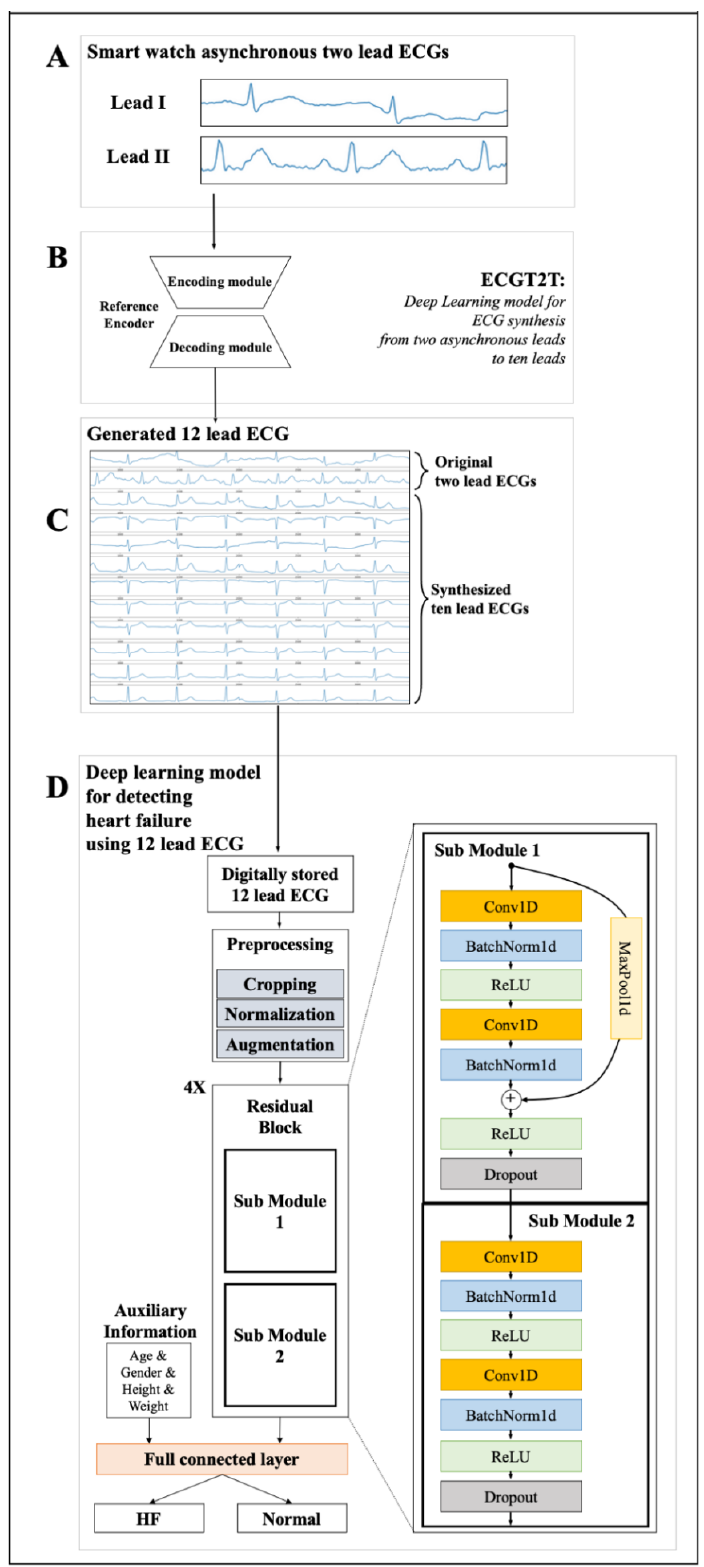
Figure 2. Architecture of deep learning model for detecting heart failure. Legend: ECG denotes electrocardiography, ECGT2T ECG synthesis from two-lead to ten-lead, and HF heart failure. ( A ) Asynchronous two lead ECGs from smart watch. ( B ) ECGT2T for synthesizing ten lead ECG from two lead ECG. ( C ) Generated twelve lead ECG which input to final AI model. ( D ) Deep learning model for detecting heart failure with reduced ejection fraction using generated twelve lead